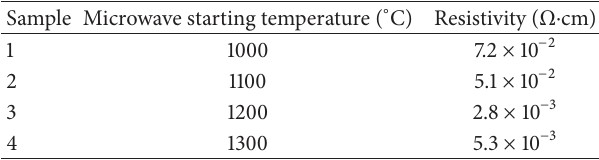
Table 3: Resistivities of AZO